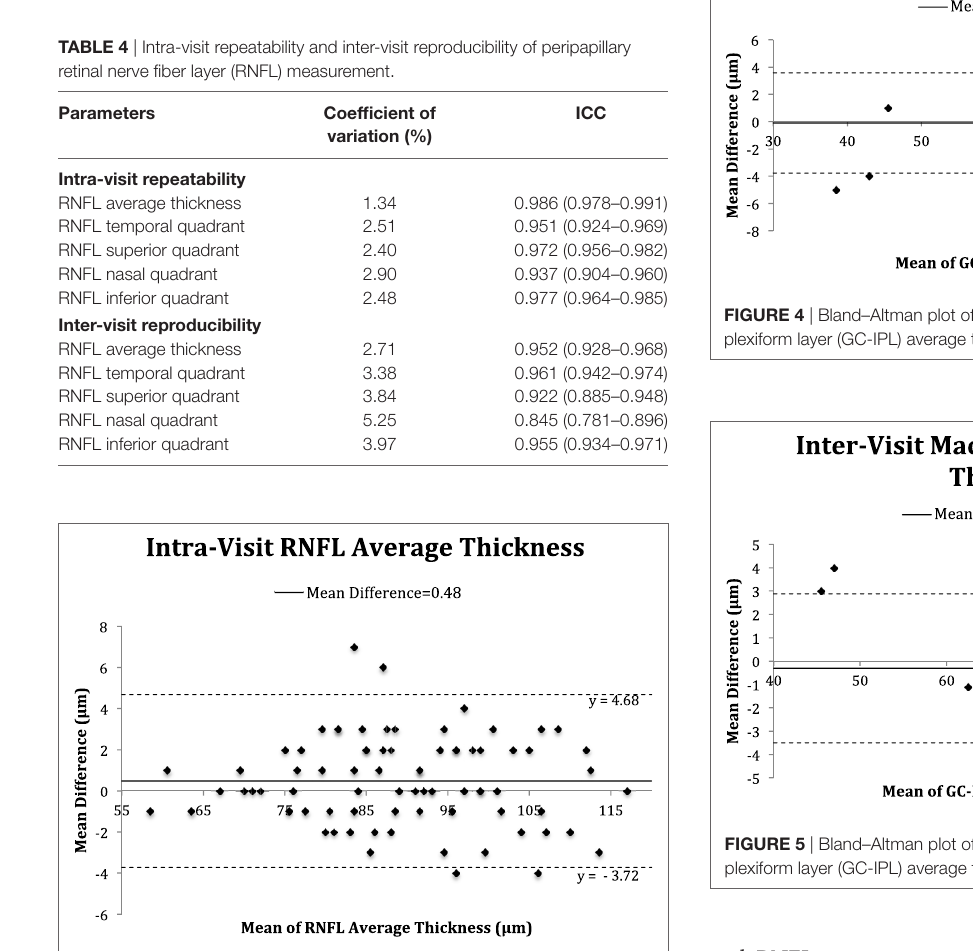
FigUre 2 | Bland–Altman plot of intra-visit peripapillary retinal nerve fiber layer (RNFL) thickness.